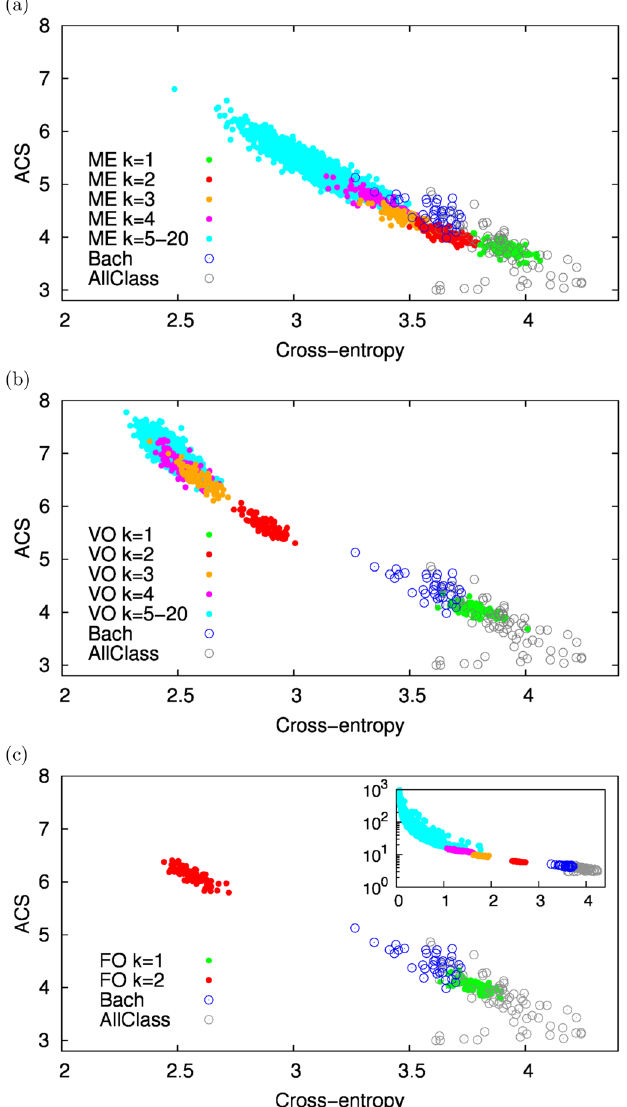
Figure 5. Borrowing vs. similarity. This figure reports the Average Common Substring (ACS) vs. the values of the cross-entropies for all the artificial sequences generated with the Maximum Entropy (ME) model ( a ), the variable-order (VO) Markov model ( b ) and the fixed-order (FO) Markov model (c) . Everything is computed with respect to the sequence of J.S. Bach’s first violin Partita (see Section S3 of the SI). Filled circles correspond to the artificial sequences. Colors code for the values of K max in each different model. In addition in each panel the empty circles reports the same quantities for other original sequences of Bach (represented with blue circles) and other classical authors - Beethoven, Schumann, Chopin, Liszt and Albeniz - (AllClass represented with grey circles). Note that the main panel for FO is truncated at values of ACS equal to 8, while the complete plot is shown in the